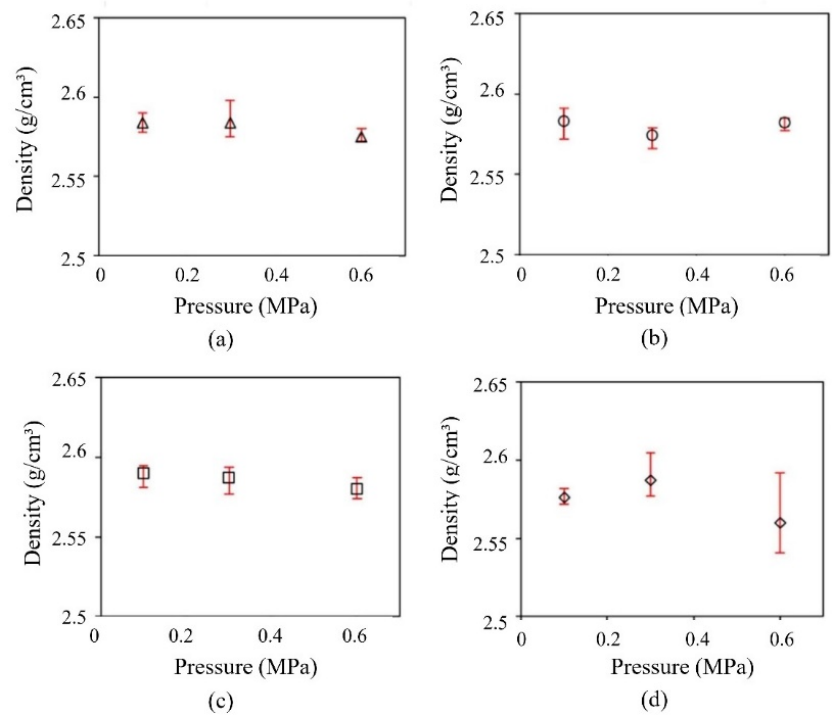
Figure 8. Effects of the pressure and temperature on the density of the green parts: ( a ) 70 °C; ( b ) 80 °C; ( c ) 90 °C; ( d ) 100 °C. Reproduced with permission from reference [86], copyright © 2016 Elsevier Ltd.